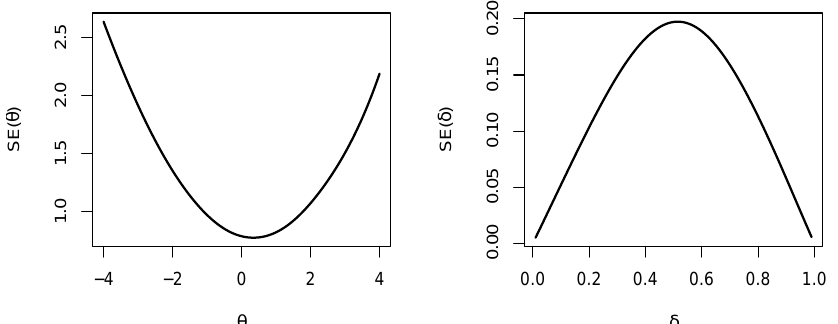
Figure 3. Conditional standard errors SE ( θ ) for the 2PL model ( left ) and SE ( δ ) for the LDS model ( right